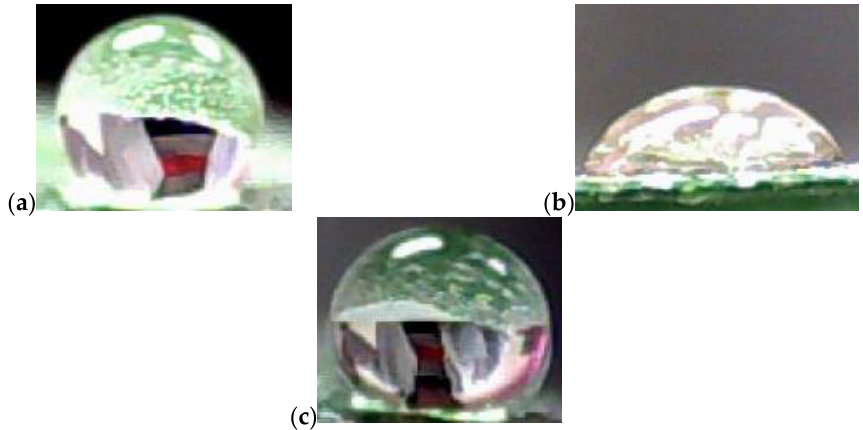
Figure 1. Examples of droplets of the liquids measured, obtained for Elaeagnus angustifolia, for the upper leaf surface; ( a ) water, ( b ) diiodomethane, ( c ) glycerine.